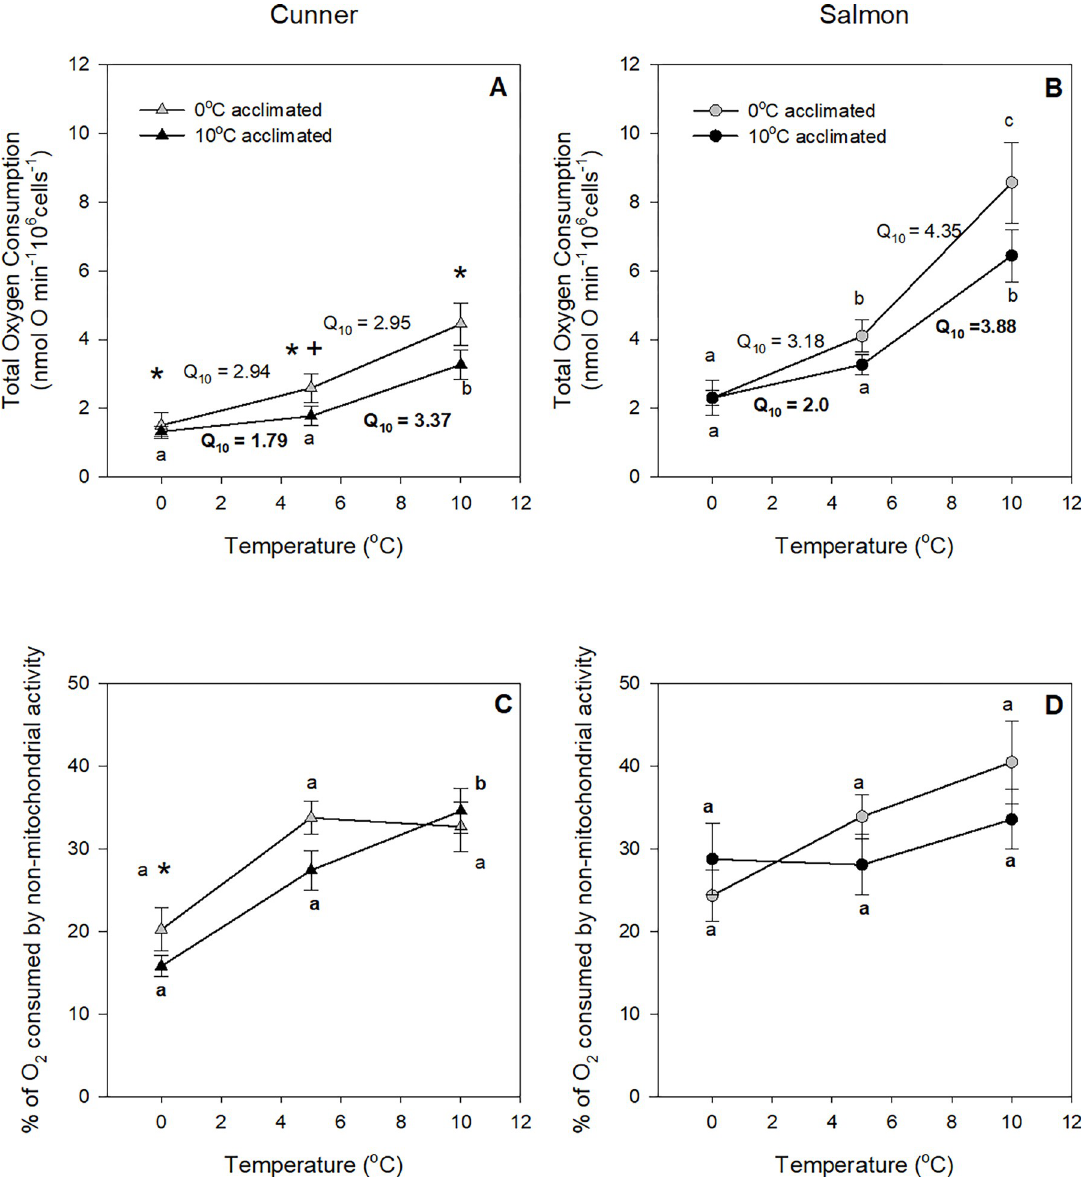
Fig 4. Total O2 consumption of isolated hepatocytes (A, B) and the percentage of O 2 consumed by non-mitochondrial activities (C, D) and by Na + -K + -ATPase activity (E, F) of isolated hepatocytes from 0 and 10˚C acclimated cunner (A, C) and salmon (B, D), measured at 0˚C, 5˚C and 10˚C. Letters indicate significant differences within a species between assay temperatures whereas an asterisk ( � ) and a plus sign (+) indicate a significant difference between species at a particular assay temperature at P < 0.05 and 0.05 < P < 0.1; as determined by a 3-way repeated measures ANOVA, followed by 2-way ANOVAs and Newman-Keuls post-hoc tests. There were no significant acclimation effects. Q 10 values and letters in bold refer to 10˚C acclimated groups. Values are means ± s.e.m., N =